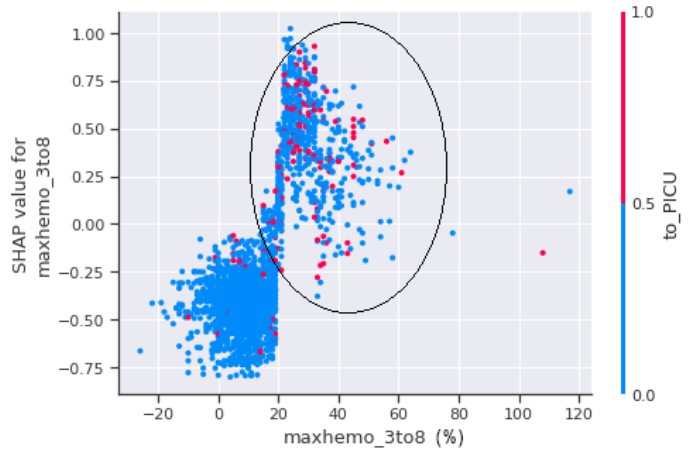
Figure 12. SHAP dependence plot between maxhemo_3to8 and